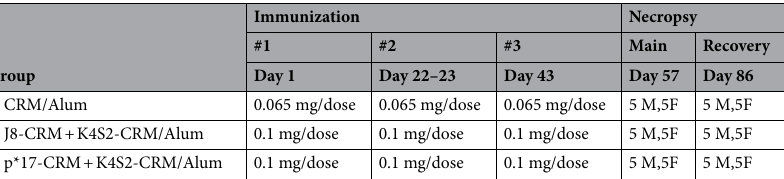
Table 1. Toxicity study groups and schedule. Alum, aluminum hydroxide adjuvant; CRM, cross-reacting material 197; M, male; F, female.